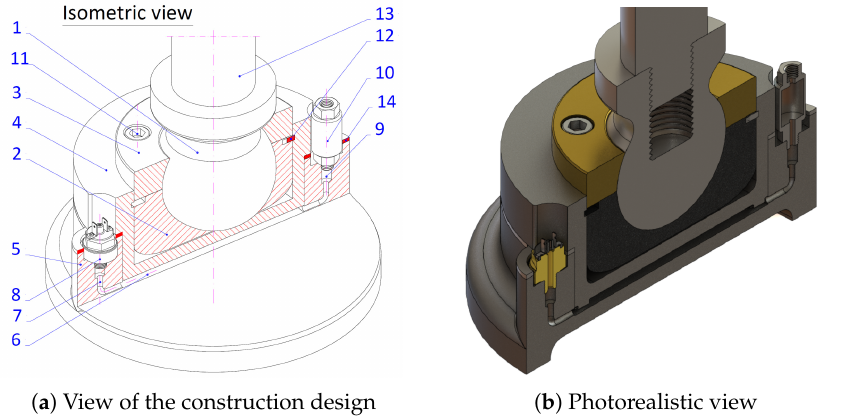
Figure 3. Crane outrigger design [45] with an incorporated pressure system and a reciprocal valve, where: 1—ball pin; 2—hemispherical bowl; 3—upper hemispherical bowl; 4—sleeve with a flange; 5—foot base, area filled with oil; 6—oil filled chamber; 7—duct; 8—pressure sensor; 9—duct; 10—reciprocal valve; 11—screw; 12—inner setting ring; 13—piston; 14—sealing